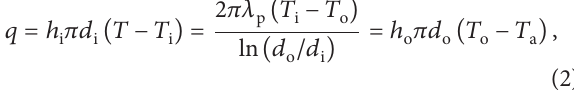
pipe, and the convective heat transfer between the outer wall of the pipe and air. The radial heat flux per unit length is the same in the heat transfer process, written as